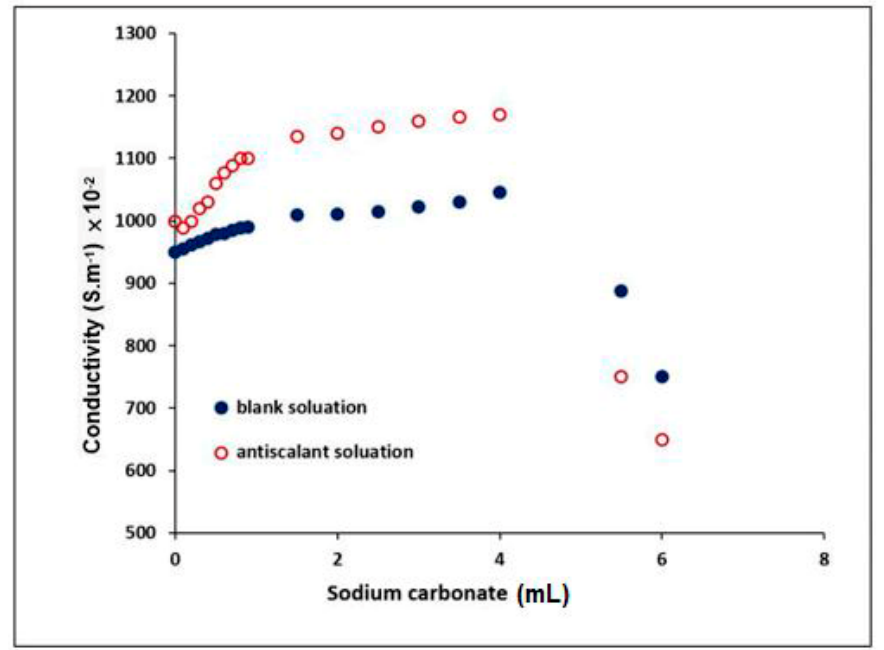
Figure 8. Variation in the conductivity in the presence and absence of 10 mg·L − 1 CA-co-GLC at 25 °C and pH 8.5.